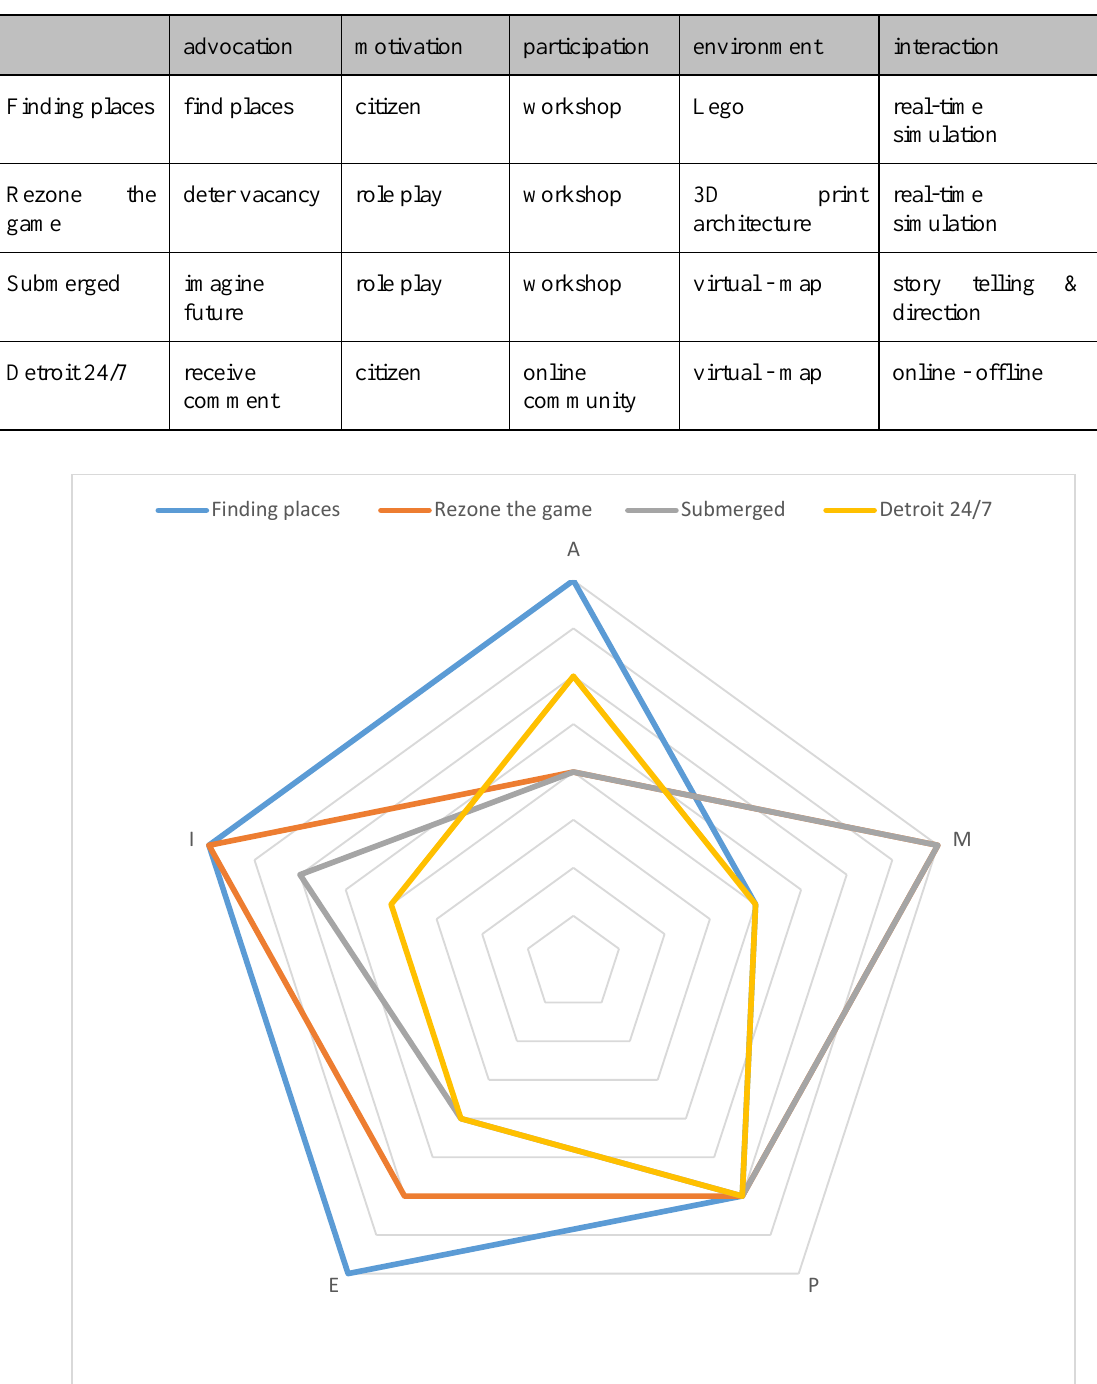
Table 1.Different forms of designing the AMPEI framework